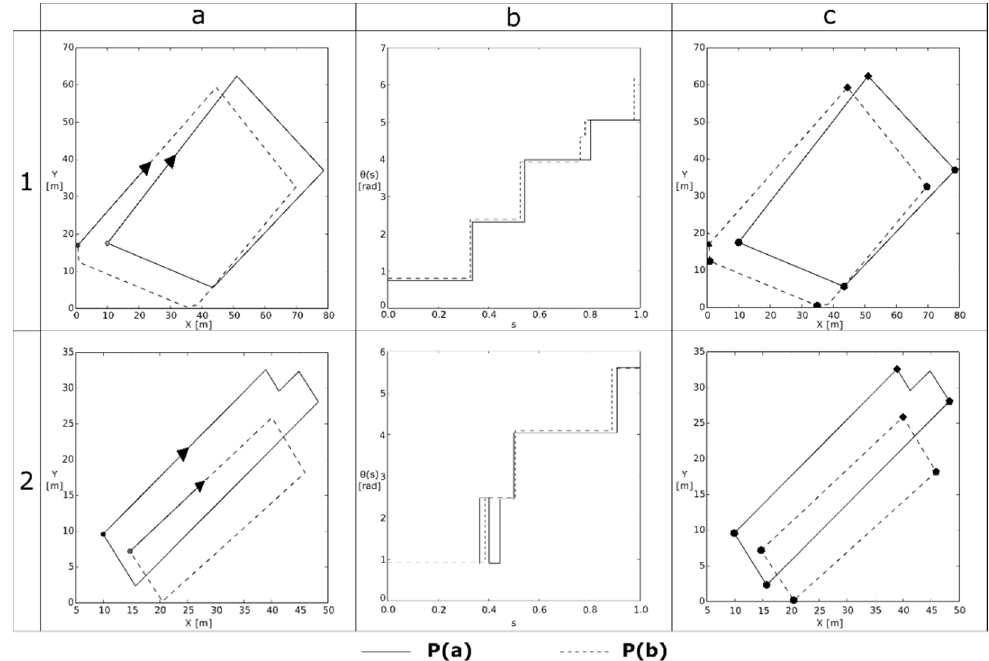
Figure 6. θ (s). Matching of homologous points. ( a ) Matched polygons, ( b ) turning functions overlapping and ( c ) matching of homologous points; homologous points are represented by a different number of polygon sides of the marker.